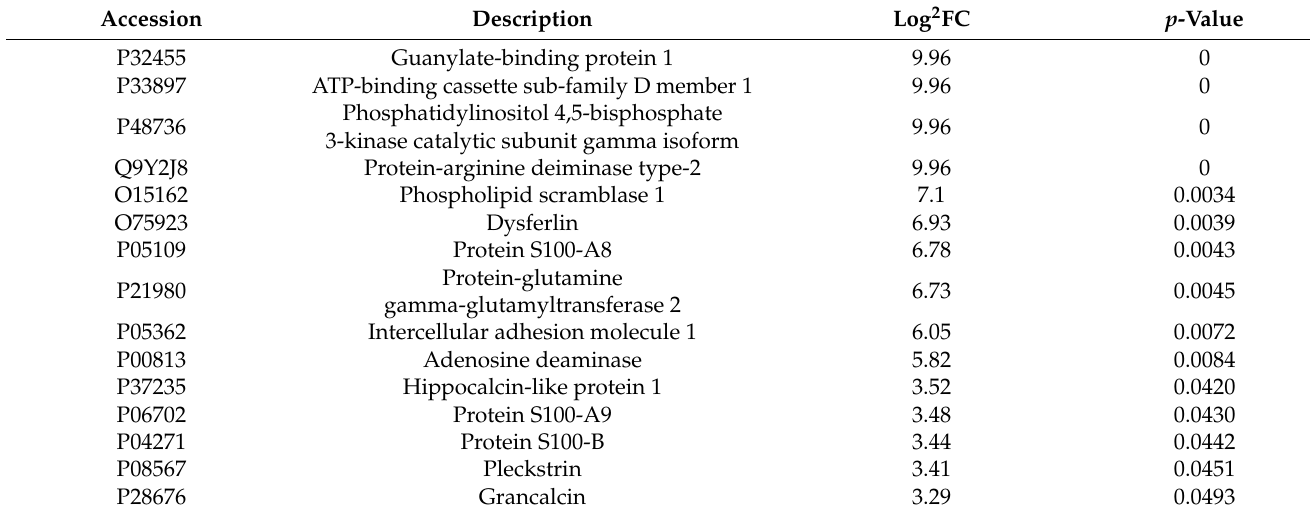
Table 1. ATRA-induced upregulation of several key proteins associated with calcium